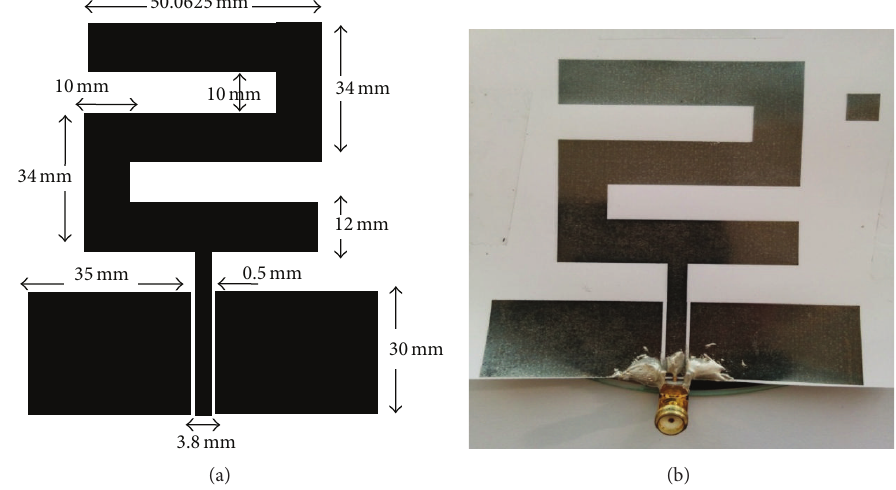
Figure 2: (a) Z-shaped CPW printed monopole antenna dimensions. (b) The printed version on glossy paper.